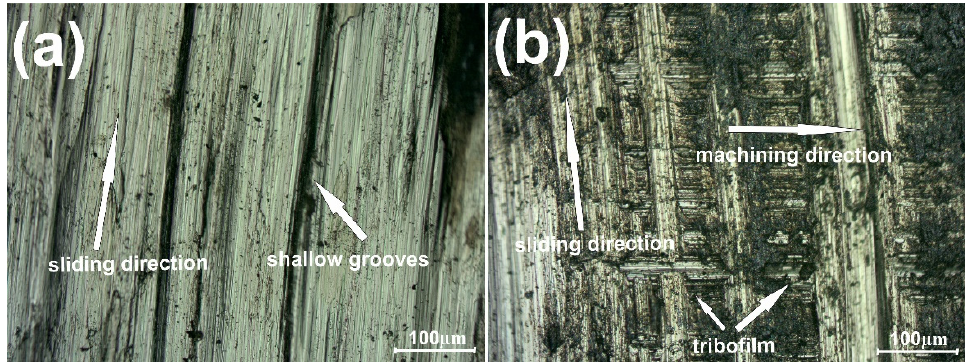
Figure 9. Surface condition of the counter-specimen mating with Ni-50%NiCr(80/20) ( a ) and Ni-